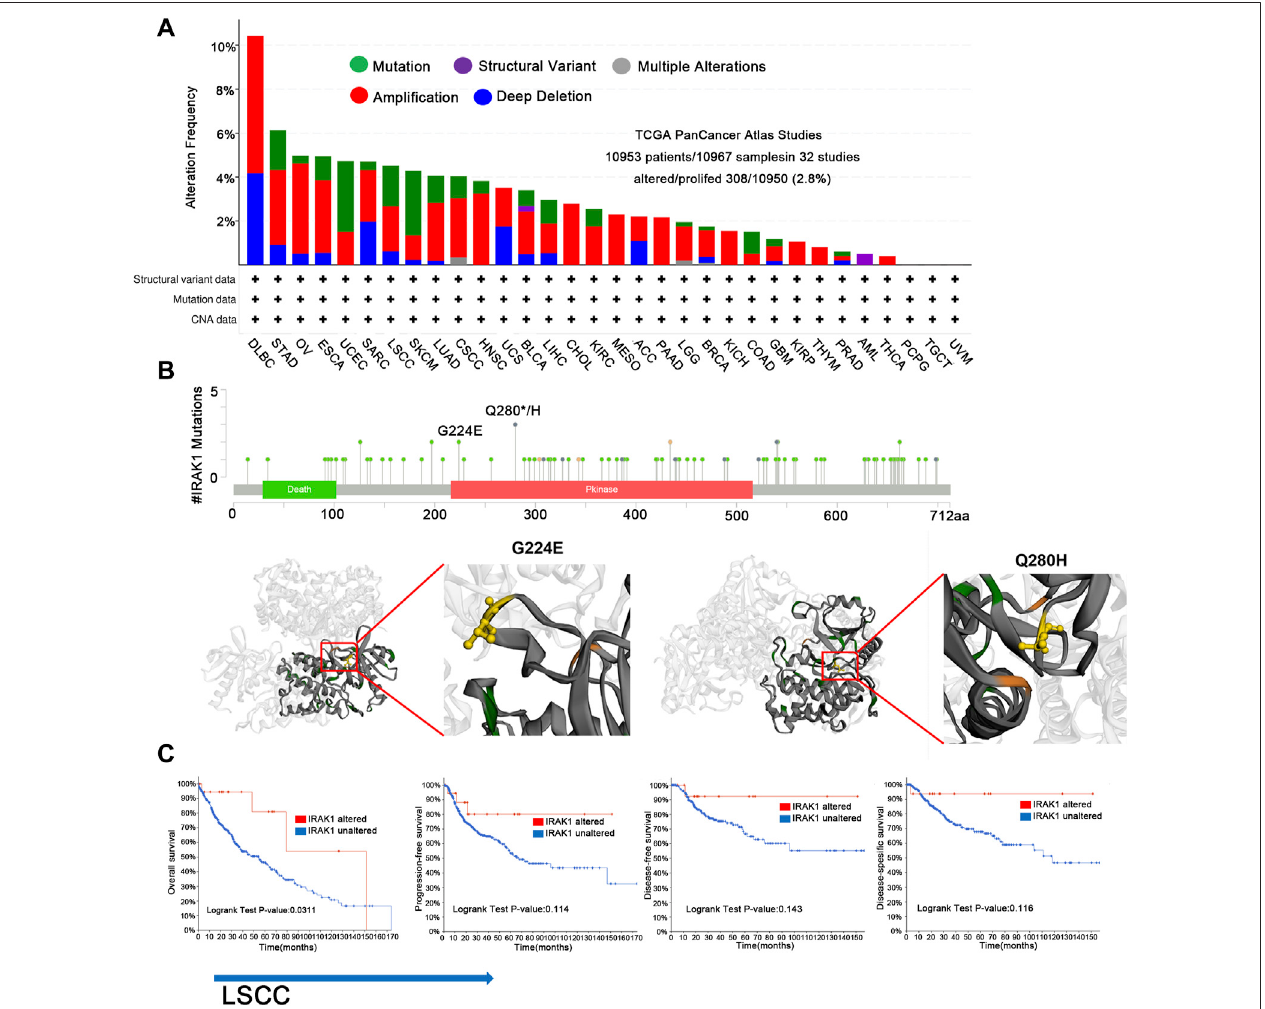
FIGURE 4 | Genetic aberration of IRAK1 in human pan-cancers from TCGA database. (A) Display of genetic aberration of IRAK1 by using the cBioportal tool. The alteration frequency was 2.8% (10,953 patients/10967 samples in 32 studies from TCGA pan-cancer panel). (B) All mutation sites of IRAK1 were distributed using cBioPortal. The most frequent mutation was Q180H/* in Pkinase site. Another mutation named G224E was also displayed. (C) Correlations of mutation status and different survival status of LSCC are shown using cBioPortal.